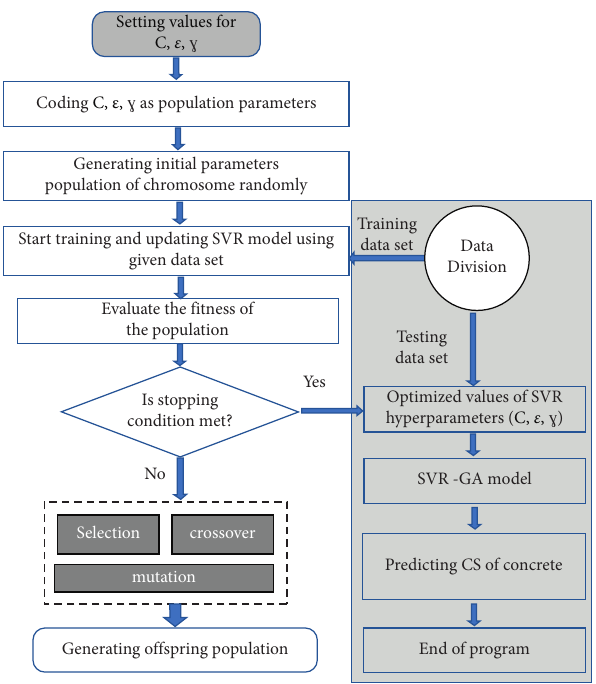
Figure 2: Incorporation of SVR with genetic